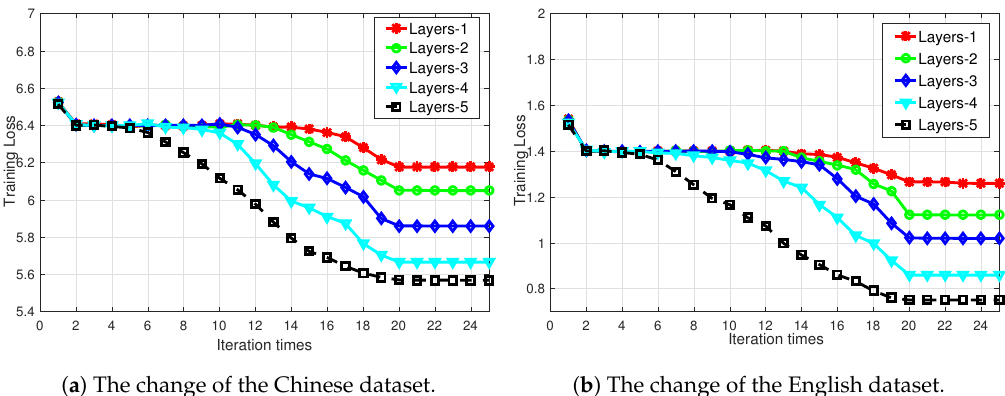
Figure 7. Training loss curve along with the change of the hidden layers from the increase in their